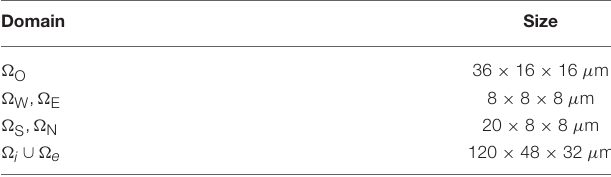
Theintracellulardomainconsistsoftwoconnectedcells,whereeachcellisacomposition of the domains (cid:127) O , (cid:127) W , (cid:127) E , (cid:127) S , and (cid:127) N (see Figure 4 ). Note that the geometry used in the remaining 3D simulations is specified in Tables 6 , 10 .